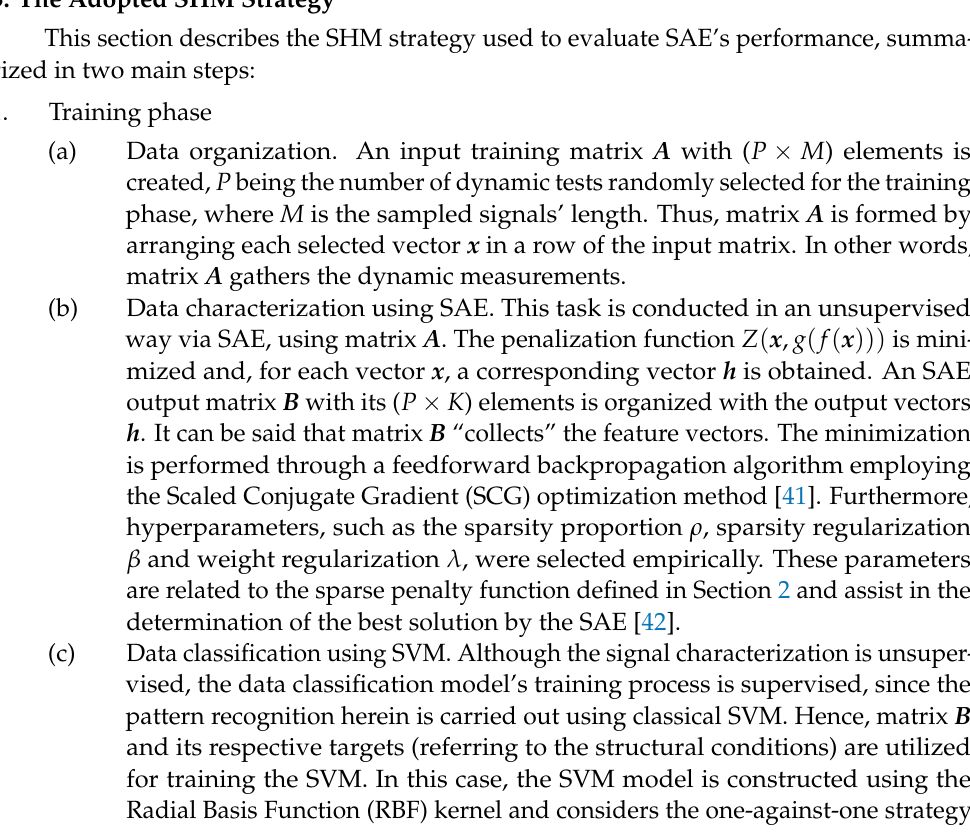
Figure 2. Sparse Auto-Encoder